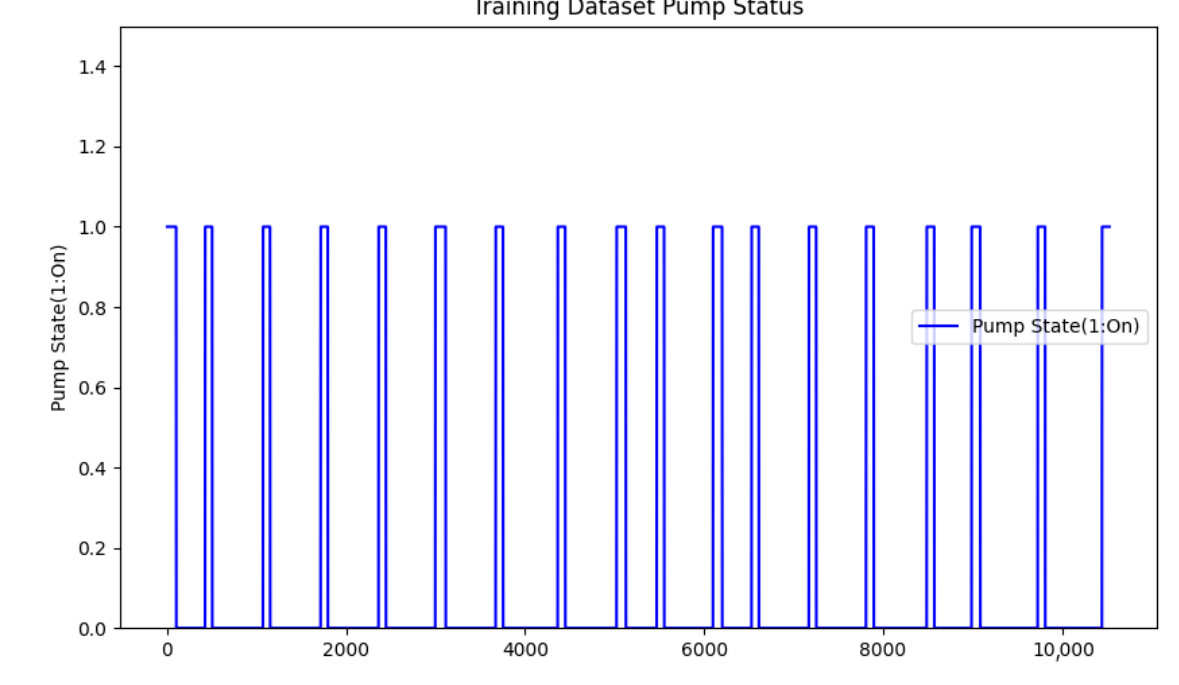
Figure 16. Training dataset pump on/off durations.